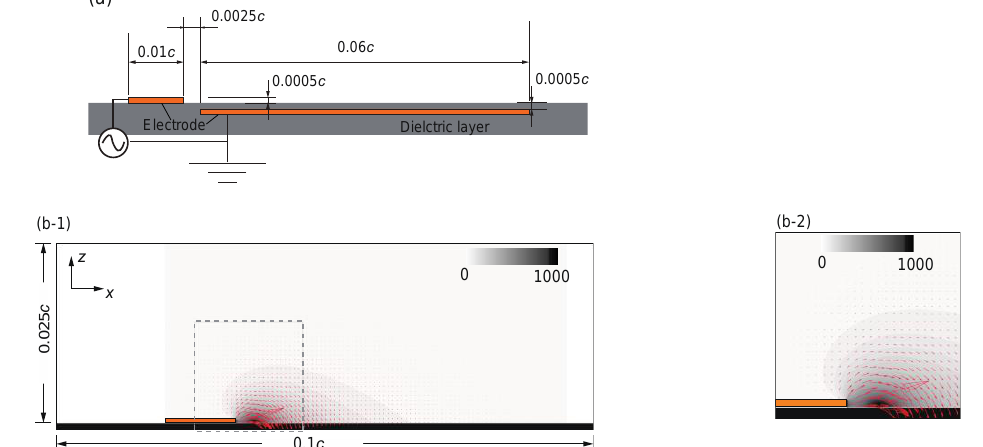
Figure 3. ( a ) Sketch of the modeled plasma actuator (PA) and spatial distribution of the DBD-PA body force model: ( b ) (1) overview; (2) zoom-up view near the exposed electrode. The magnitude of the DBD-PA body force was represented by multiplying the nondimensional